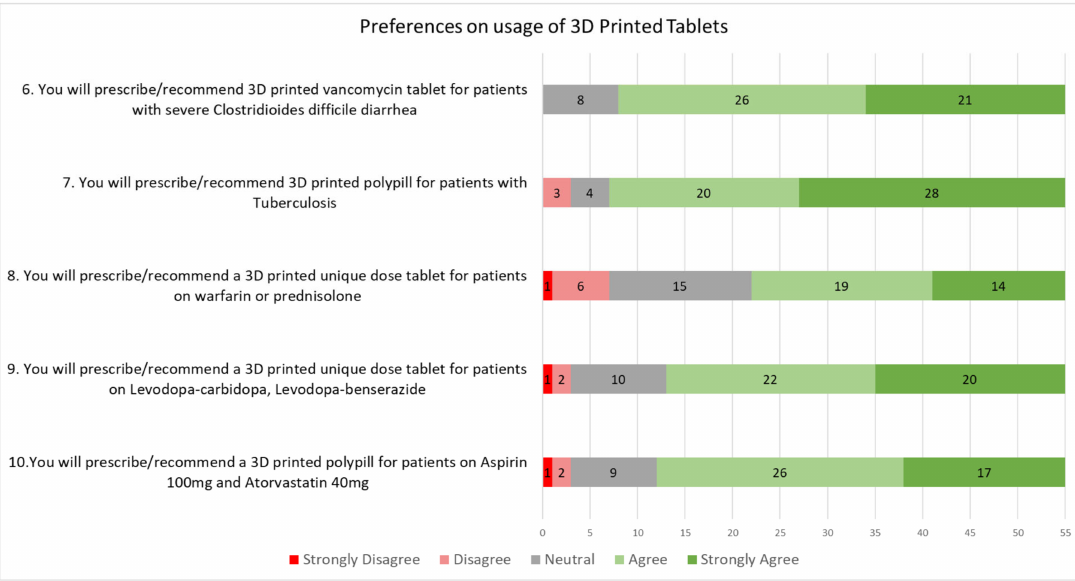
Figure 3. Responses to statements about preferences on usage of 3D printed